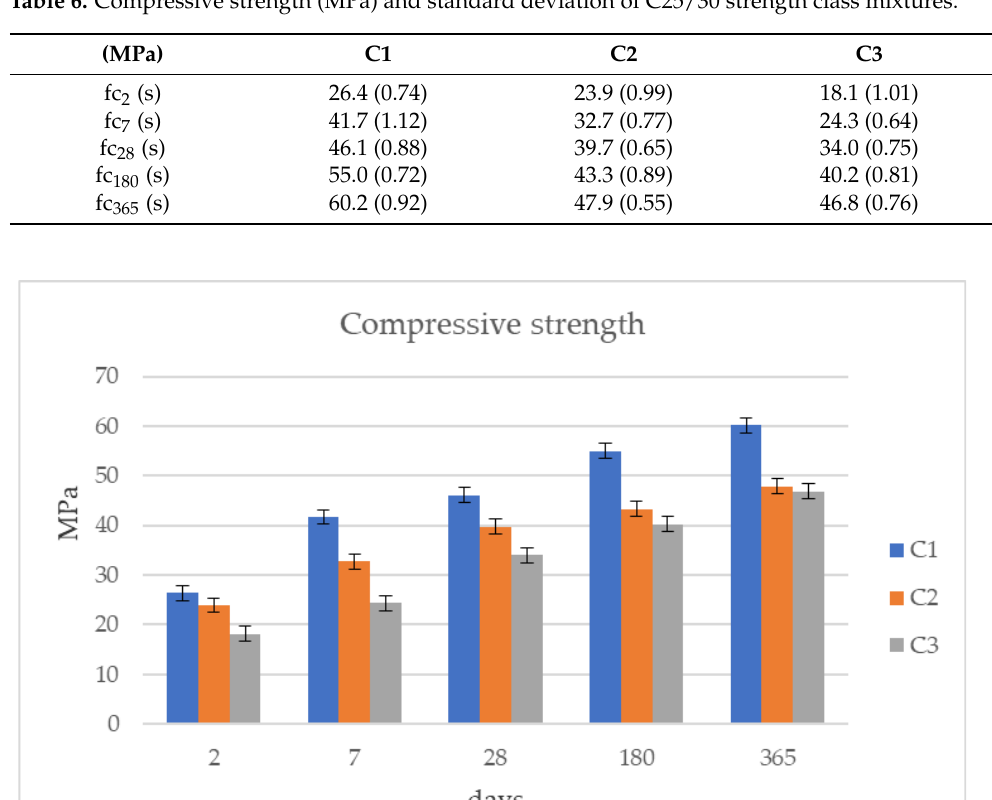
Table 6. Compressive strength (MPa) and standard deviation of C25/30 strength class mixtures.